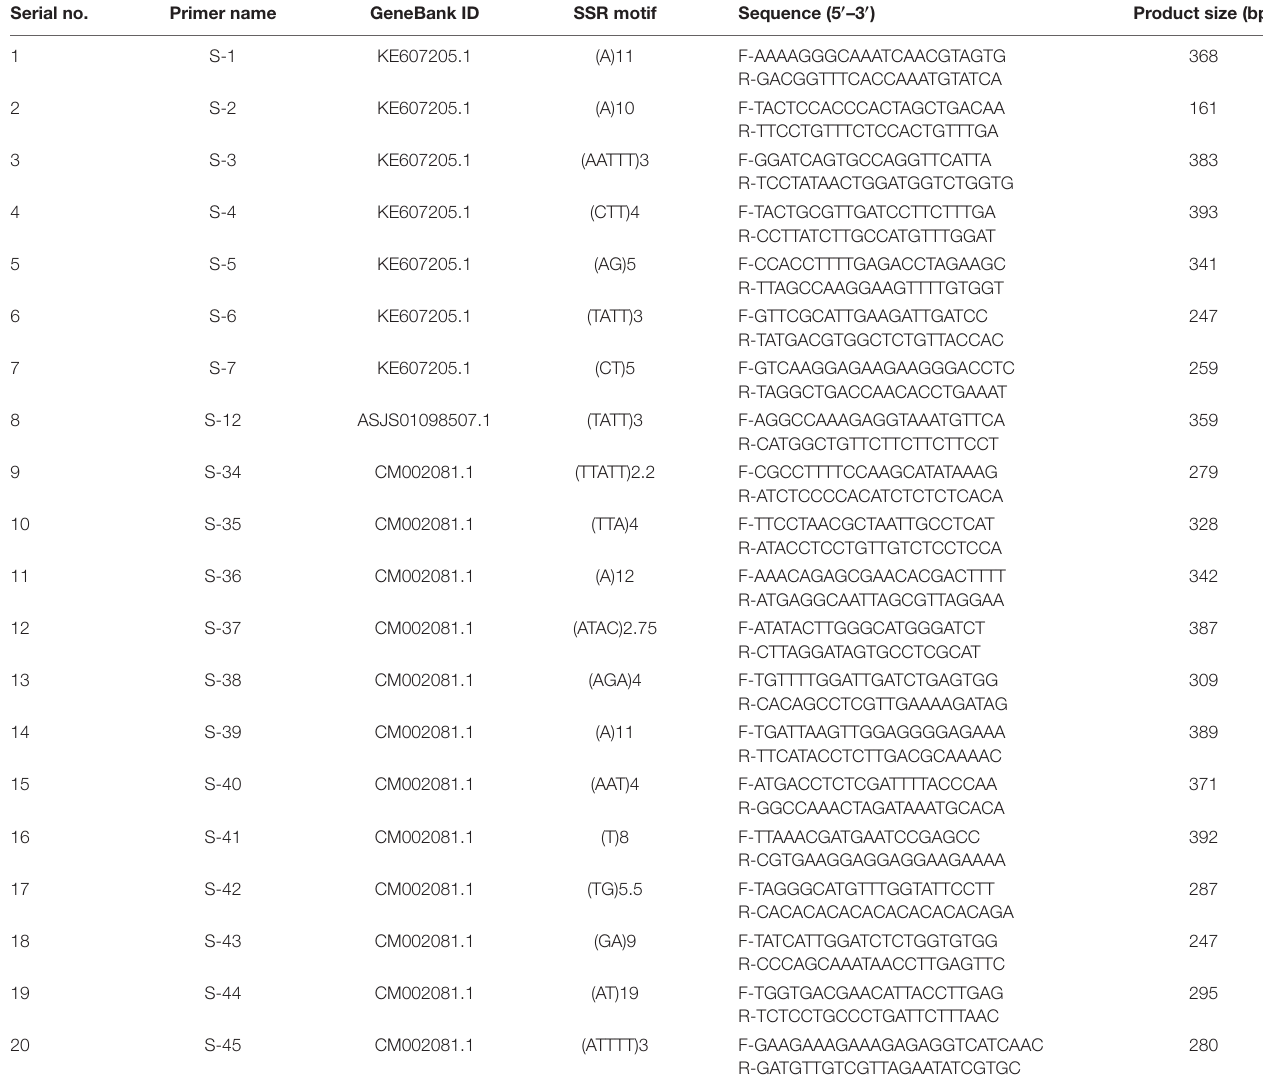
TABLE 1 | Details of SSR primers used for the study. Serial no.